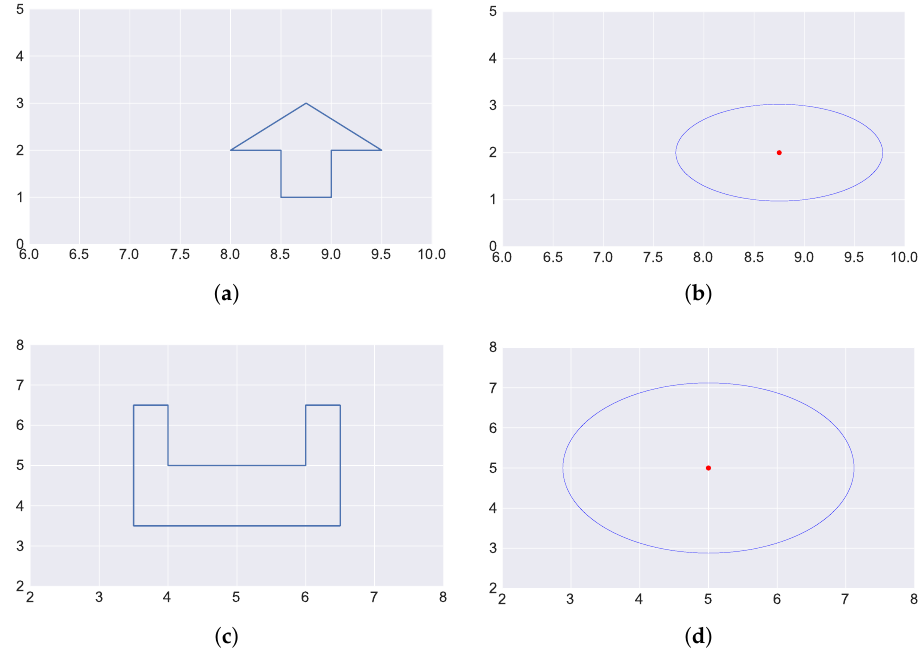
Figure 5. Sample inputs and outputs of COA. ( a ) Input sample 1. ( b ) Output sample 1. ( c ) Input sample 2. ( d ) Output sample